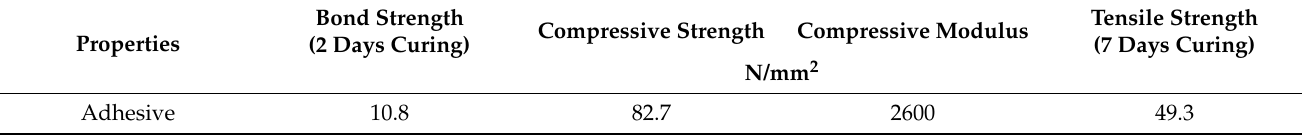
Table 4. Material properties of the chemical